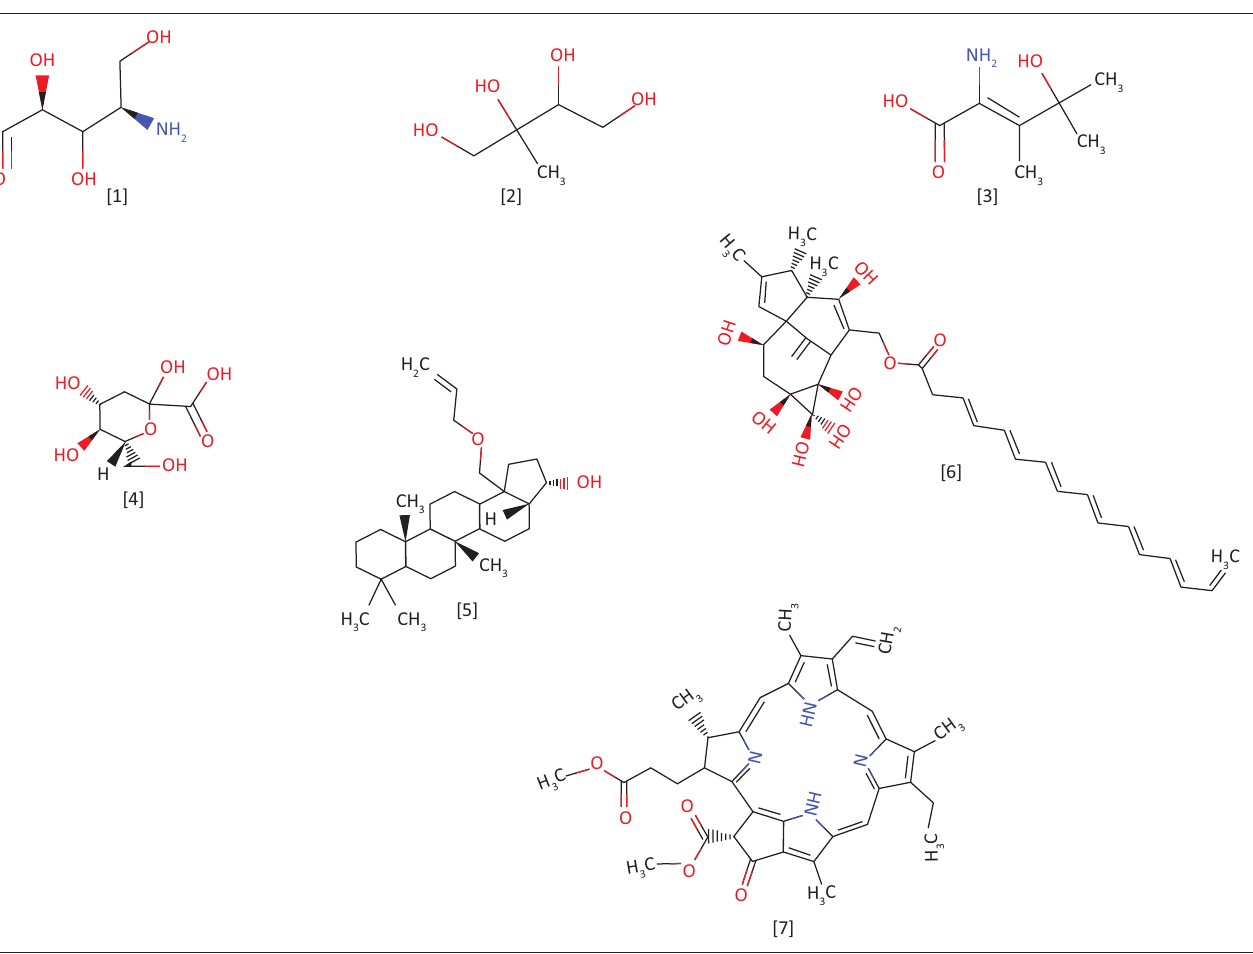
FIGURE 9: Chemical structures of known identified compounds in Alchornea laxiflora